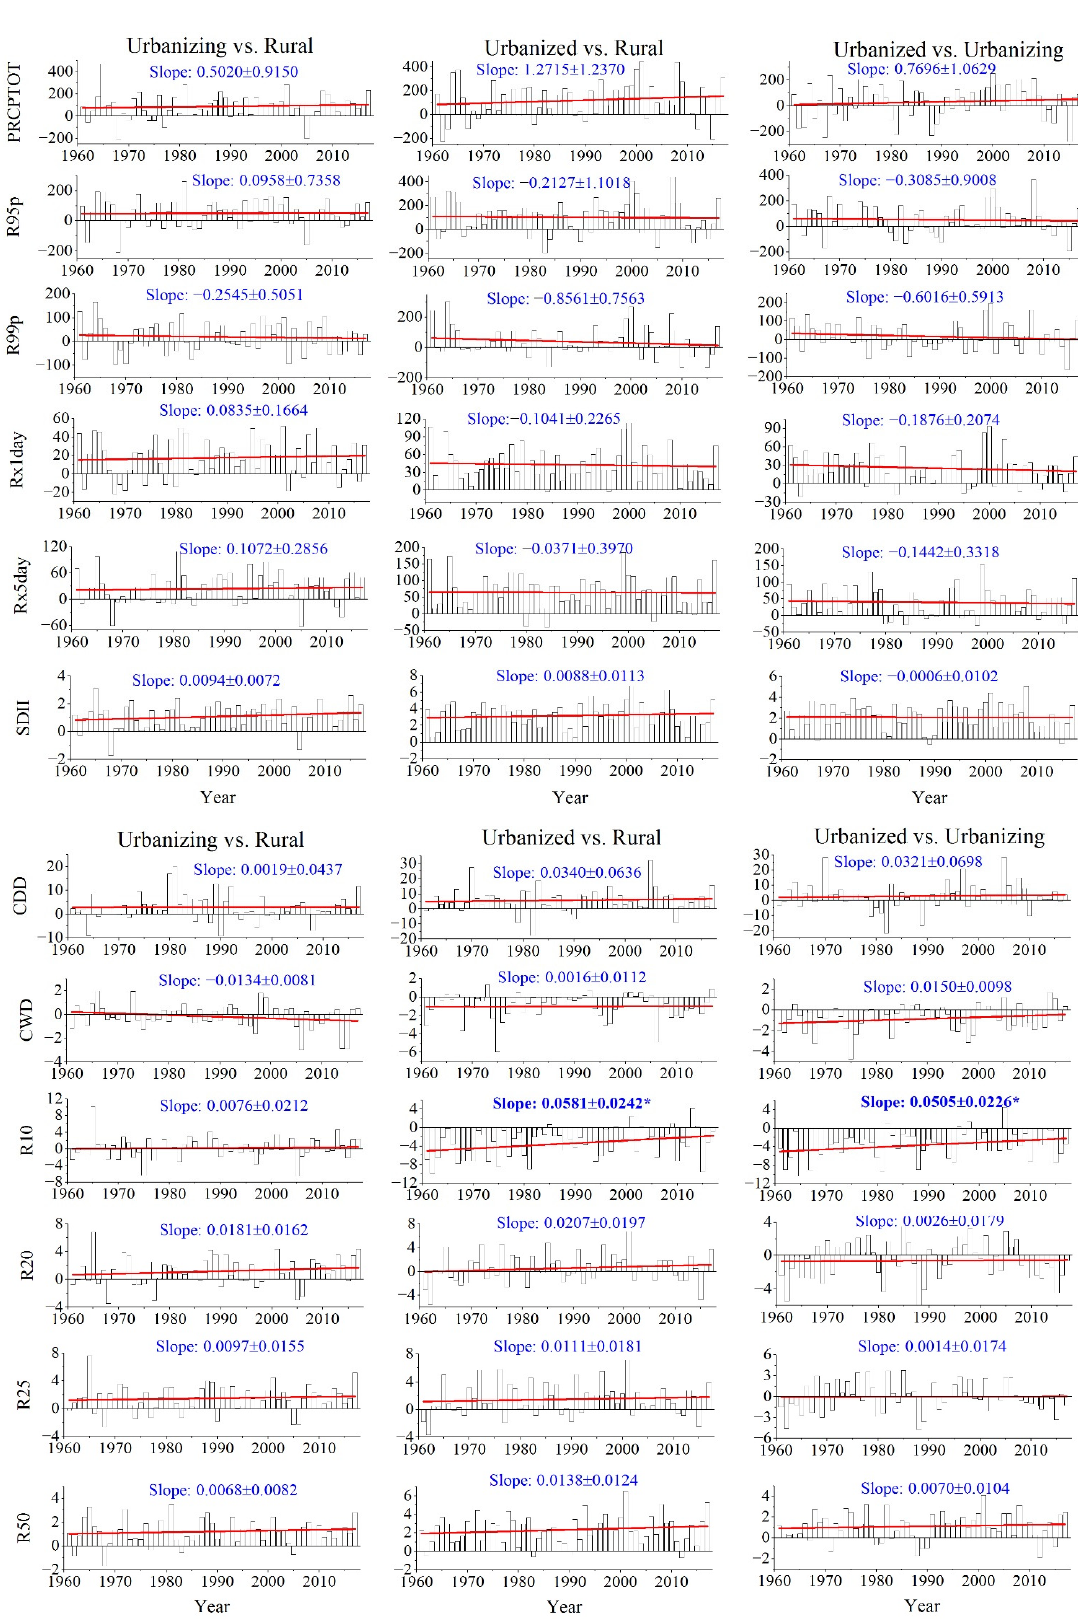
Figure 9. Trends of urban–rural differences in precipitation extremes over the PRD during 1961–2017. The sign * denotes a significant trend at the 0.05 level.